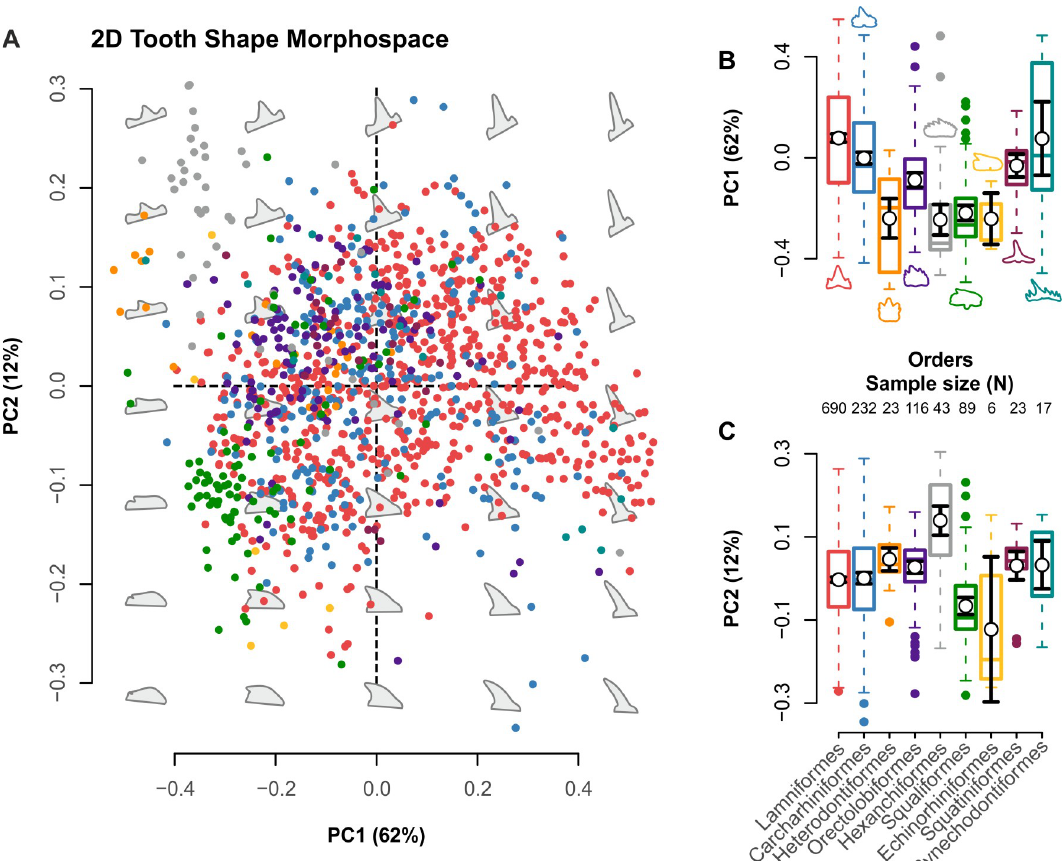
Fig 1. Morphospace distribution. (A) Multivariate shape space for the N = 1,239 global selachimorph tooth sample. Theoretical backtransform tooth shapes (gray) indicate shape variability across morphospace as defined by PC1/PC2. (B, C) Box-and-whisker plots indicating average morphospace occupation along (B) PC1 and (C) PC2. Error bars represent 95% confidence intervals. Proportion of variance and group sample sizes are listed in the axis labels. The data used in this analysis can be accessed online